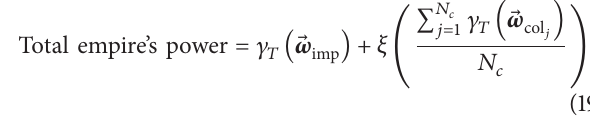
Step 2. 𝑁 of most powerful (in terms of SNR) countries are imp chosen as imperialists to form empires and the rest of 𝑁 col countries are called colonies. Figure 2(a) depicts the initial colonies for each empire. The initial number of colonies for with respect to the an empire is randomly selected from 𝑁 col ) , which is its corresponding empire’s imperialist power (𝑝 imp normalized